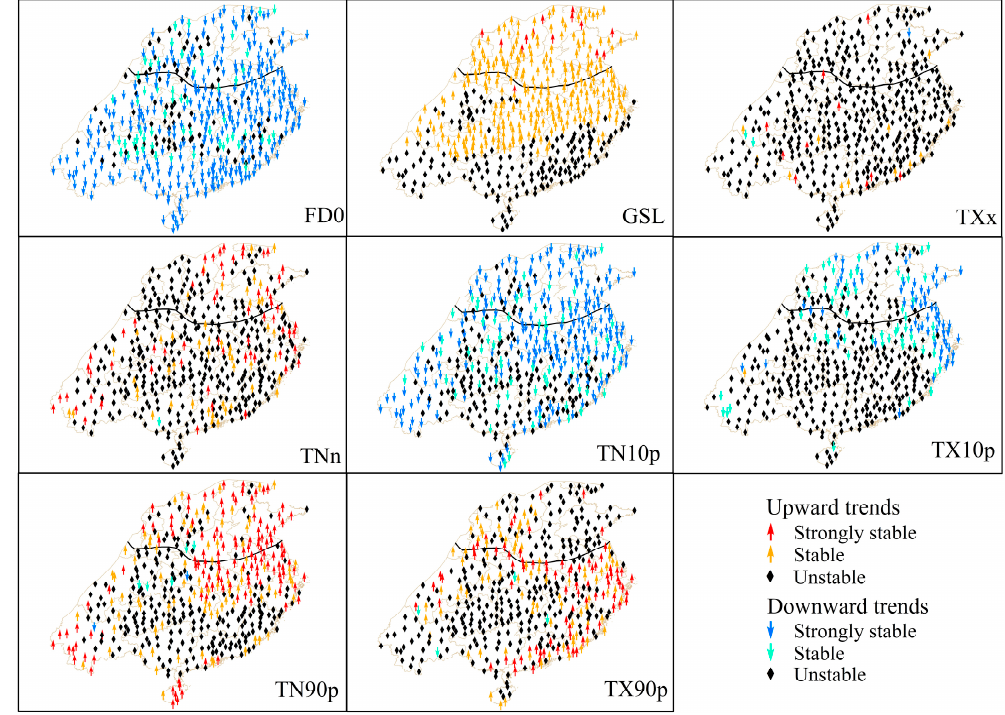
Figure 6. Stabilities of the statistically significant trends at each meteorological station for extreme temperature indices during the growth period of October 1961 to May 2016.